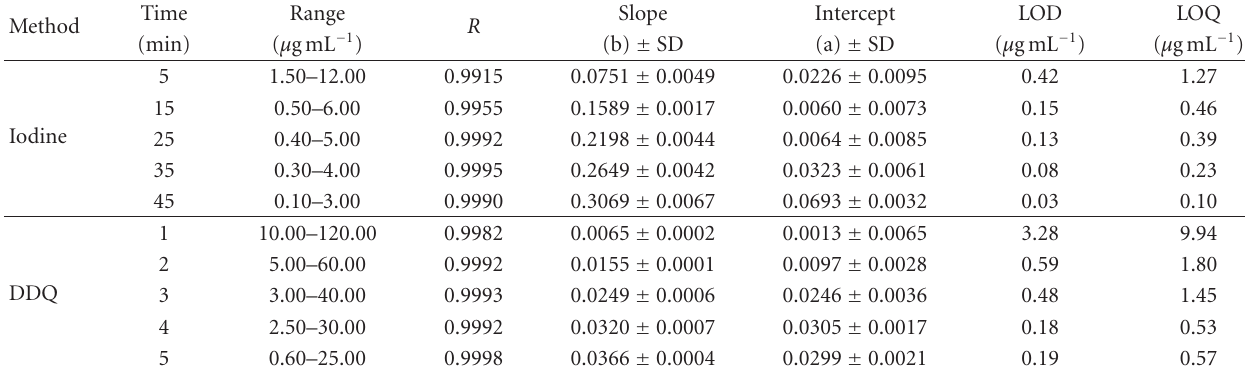
Table 4: Analytical parameters for the proposed fixed time methods for determination of